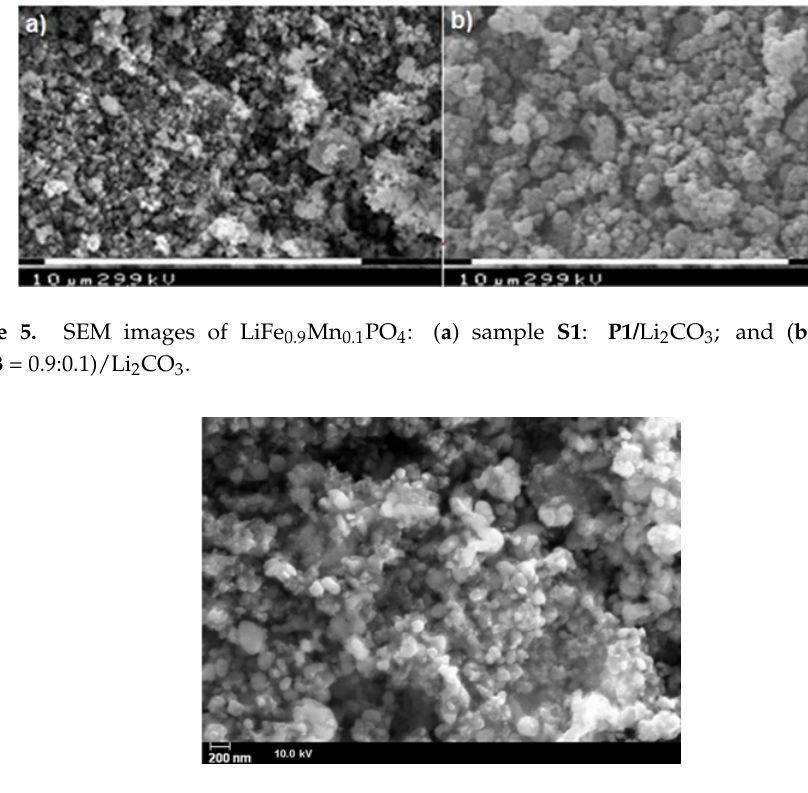
Figure 7. ( a ) Electrochemical galvanostatic tests at C/5 rate for samples S1 and S2 ; and ( b ) voltage profile of sample S1 ; Voltage profile of Sample S2 . 3.3. Characterization of LiMn x Fe (1 − x) PO 4 (with x = 0, 0.05, 0.1, 0.5, 0.9, 0.95, and 1) Furthermore, taking in consideration this electrochemical results, a series of LiMn x Fe (1 − x) PO 4 (with x = 0, 0.05, 0.1, 0.5, 0.9, 0.95 and 1), obtained only from P2 and/or P3 and Li 2 CO 3 precursors, have been prepared and characterized. The powder X ‐ ray diffraction spectra of LiMn x Fe (1 − x) PO 4 (x = 0; 0.05; 0.1; 0.5; 0.9; 0.95; 1) are shown in Figure 8. As it can be observed, substituting manganese in lithium manganese phosphate with iron(II) slightly moves all peaks to the right, although the similarity of the crystalline structure of the two lithium metal(II) phosphates is clear. Moreover, in Table 3 the refinement results for cell parameters and crystallites size T, calculated by Scherrer equation (T = 0.9 ∙λ / Δ (2 θ ) ∙ cos θ ), have been reported and it is clear that passing from LiFePO 4 to LiMnPO 4 the cell size slightly increases, while the crystallites size decreases. In some samples (x = 0.05; 0.5; 0.95; 1) the presence of iron phosphide (Fe 2 P) impurities have been detected. Replacement of the bivalent hetero ‐ metal atom does not affect the crystalline structure of pure lithium iron and manganese phosphate. Indeed the crystalline structure (space group) is the same but substitution of iron with manganese (different atomic radius) in effect shifts the peak positions slightly and this is visible also in the reported XRD spectra. What is important here is that for all samples one, unique crystalline phase has been detected while the mechanic mixture clearly shows peak splitting due to the presence of two crystalline phases. On the other hand, when simply mixing together (0.5:0.5) LiMnPO 4 and LiFePO 4 , the observed X ‐ ray diffractogram shows a splitting of the peaks, as reported in Figure 9. Actually, in this case two similar crystalline structures presenting slightly different peak positions are present, therefore, two distinct phases and a splitting of peaks are evident. It is worth to note that in the case of manganese ‐ iron phosphate synthesized from metal(II) phenylphosphonate mixtures as described before, even when Mn(II) and Fe(II) are present in equal ratio, as in LiMn 0.5 Fe 0.5 PO 4 , formation of only one crystalline phase has been observed. The results of BET analysis for cathodic powders obtained are reported in Table 4 along with the carbon weight percentage determined by elemental analysis, which ranges from 10% to 13.7%. This